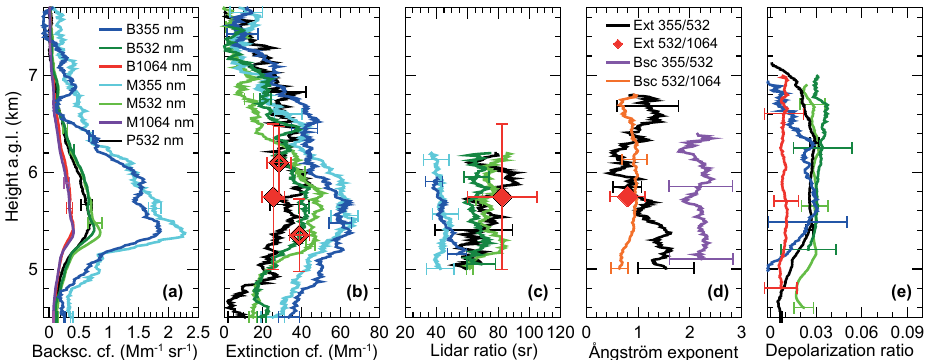
Figure 2. The 2.5h mean profiles (20:45–23:15UTC, see Fig. 1) of optical properties in the tropospheric smoke layer: (a) particle backscatter coefficient at three wavelengths measured with three lidars (BERTHA, B; MARTHA, M; and 532nm Polly, P), (b) respective extinction coefficients (colors as in a ), (c) extinction-to-backscatter ratio (lidar ratio, colors as in a ), (d) backscatter-related (Bsc) and extinction-related (Ext) Ångström exponents (BERTHA only), and (e) particle linear depolarization ratio (colors as in a ). Error bars indicate the retrieval uncertainty (1 standard deviation). In the case of the 1064nm extinction coefficient, a height profile could not be determined. Therefore, only a few values for retrieval window length (least-squares method) of 750 and 1500m (indicated by vertical bars) are shown. The 1064nm lidar ratio is given for the 1500m retrieval interval length. The 1064nm depolarization ratio was measured between 23:50 and 00:30UTC. For more details, see Sect. 2.2.